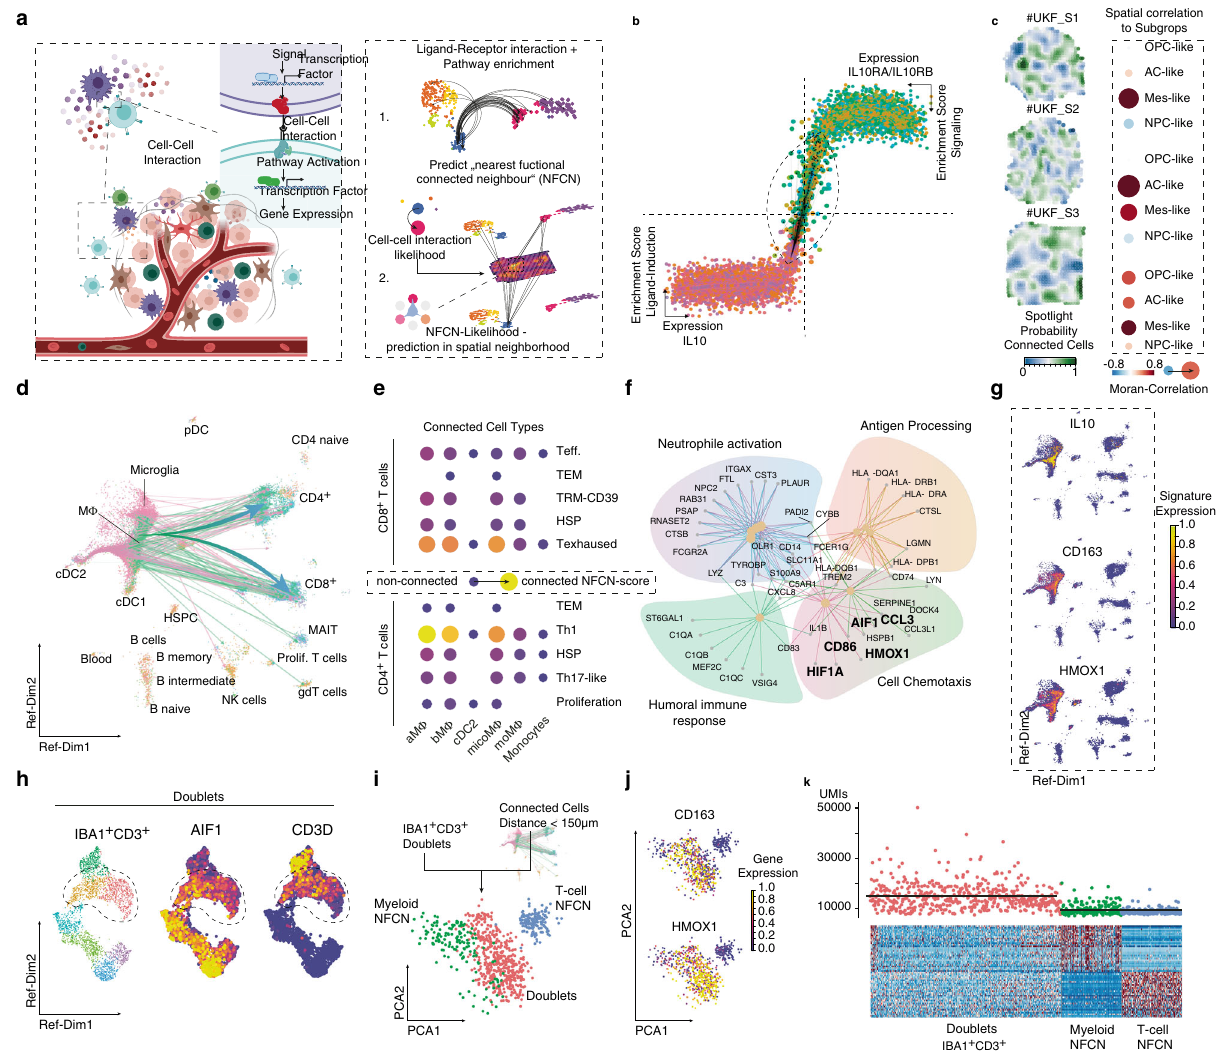
Fig. 5 Neighborhood analysis of myeloid – lymphoid interactions. a Work fl ow exploring cell – cell interactions using two approaches: (1) Predict functional neighbors based on de fi ned ligand-receptor interaction. (2) Validation in spatial transcriptomic datasets. b Scatter-cell – cell interaction plot from the “ Nearest Functionally Connected Neighbor ” algorithm (NFCN) as explained in supplementary results. c Spatial alignment of highly connected cell pairs from the NFCN analysis, right side. Spatial correlation analysis is illustrated at the left side. The juxtaposition of connected cells and the GBM subtypes was quanti fi ed using Moran statistics. Cells are colored accordingly to the myeloid/T cell cluster of origin. d 2D UMAP presentation of the connected cells. Arrows indicate the most likely cell connection between the myeloid and T cell compartment. e Dot plot of cluster-wise connectivity of myeloid (on the bottom) and T cell clusters (right side). Color and size indicate the NFCN-score. f Gene set enrichment analysis of top fi ve enriched pathways in highly connected myeloid cells. g 2D UMAP representation with gene expression. h Doublet analysis of mixed CD3 + /IBA1 + positive doublets. The dimensional reduction illustrates the identi fi ed doublets. The highlighted doublet population demonstrated the CD3 + /IBA1 + positive doublets . i Fusion of the connected myeloid and lymphoid cells illustrated the gene expression similarity compared to the CD3 + /IBA1 + positive doublets. j Gene expression of the cells/ doublets presented in i . k Heatmap of the doublets (left) and single cells (right). The UMIs con fi rmed the status as single cell or doublet. Signature gene expression of either myeloid or lymphoid cell was both expressed in the